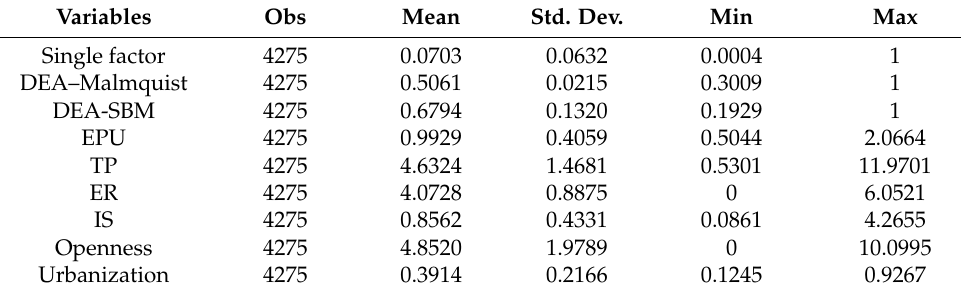
Table 2. Summary statistics of the